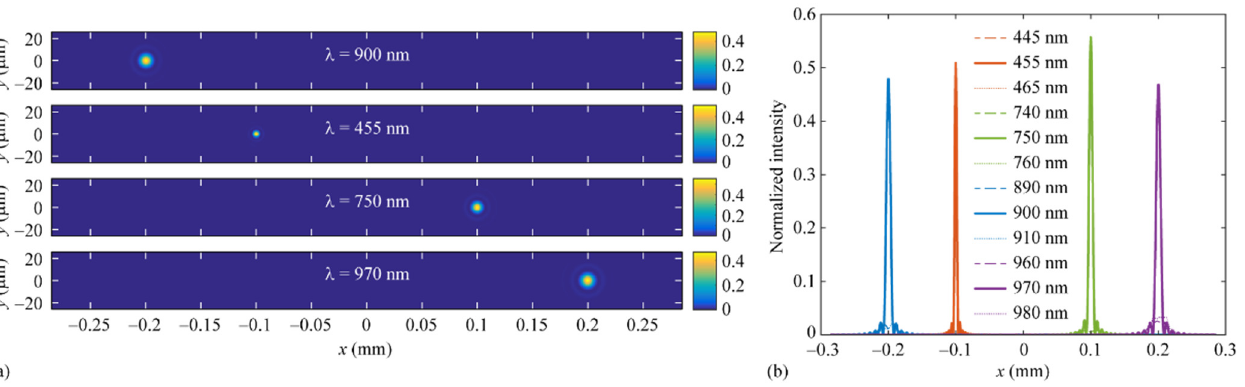
Figure 5. Microrelief of the MWDL focusing the wavelengths λ 1 = 900 nm, λ 2 = 455 nm, λ 3 = 750 nm, and λ 4 = 970 nm to four points.